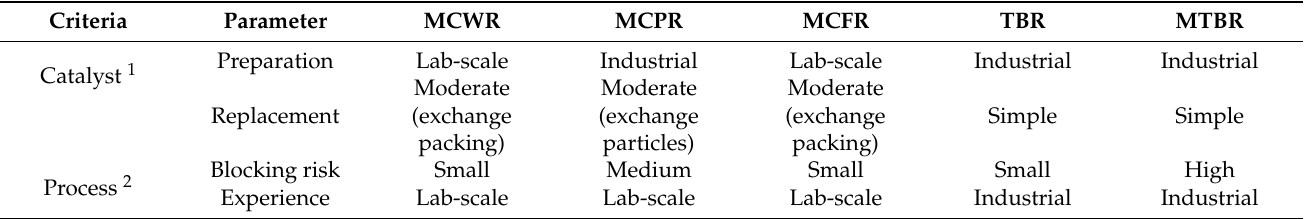
Table 3. Comparison of the 5 investigated reactor configurations based on qualitative